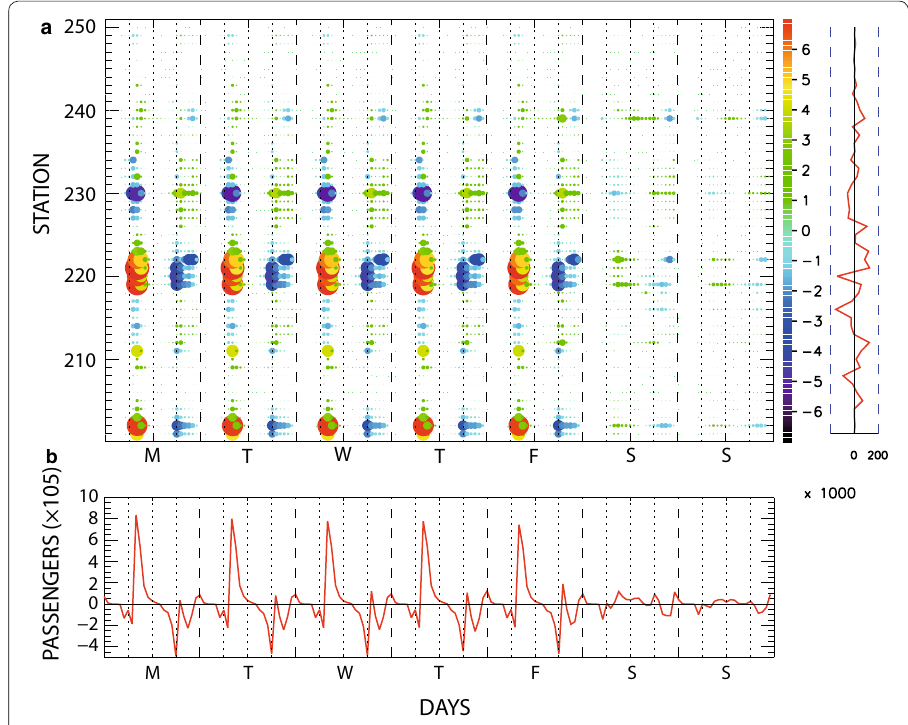
Fig. 4 The weekly patterns of the number of alighting minus boarding passengers for Subway Line #2: a hourly and total number of alighting minus boarding passengers at each of the 50 subway stations; b num‑ ber of alighting minus boarding passengers in all stations